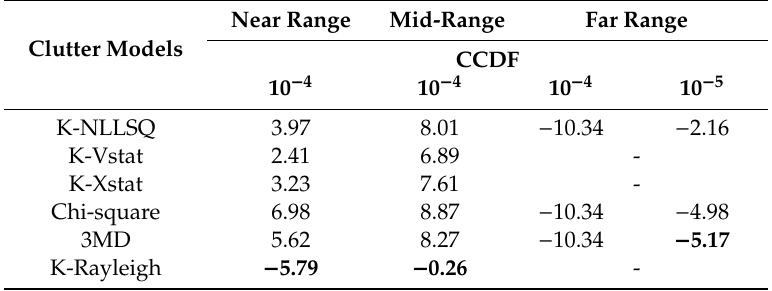
Table 3. Estimated threshold errors for di ff erent clutter models for linearly acquired F-SAR data.